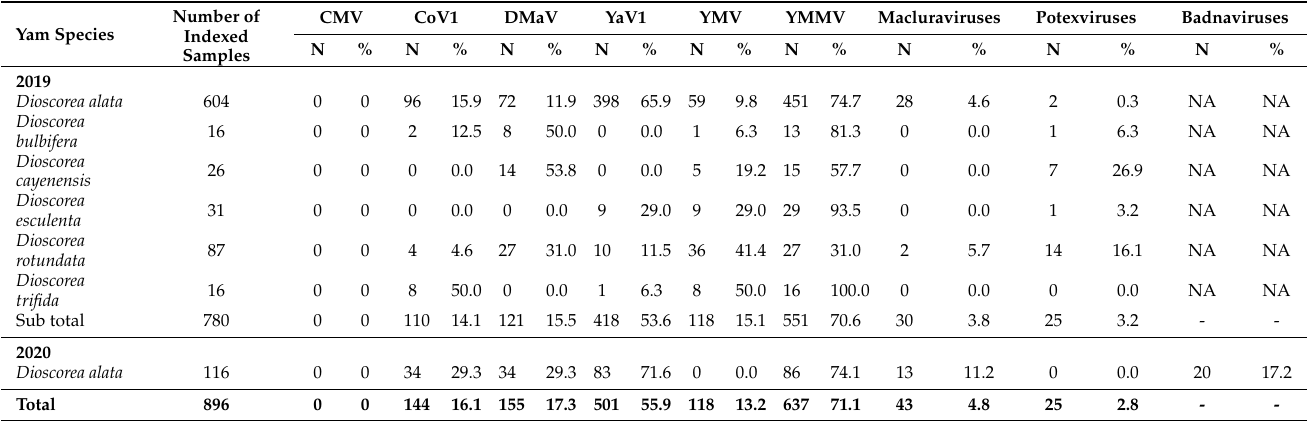
Table 1. Results of the prevalence survey of yam viruses in Guadeloupe. In addition to the overall number of samples indexed for each yam species, the number (N) and percentage (%) of infected samples are given for each yam species/virus